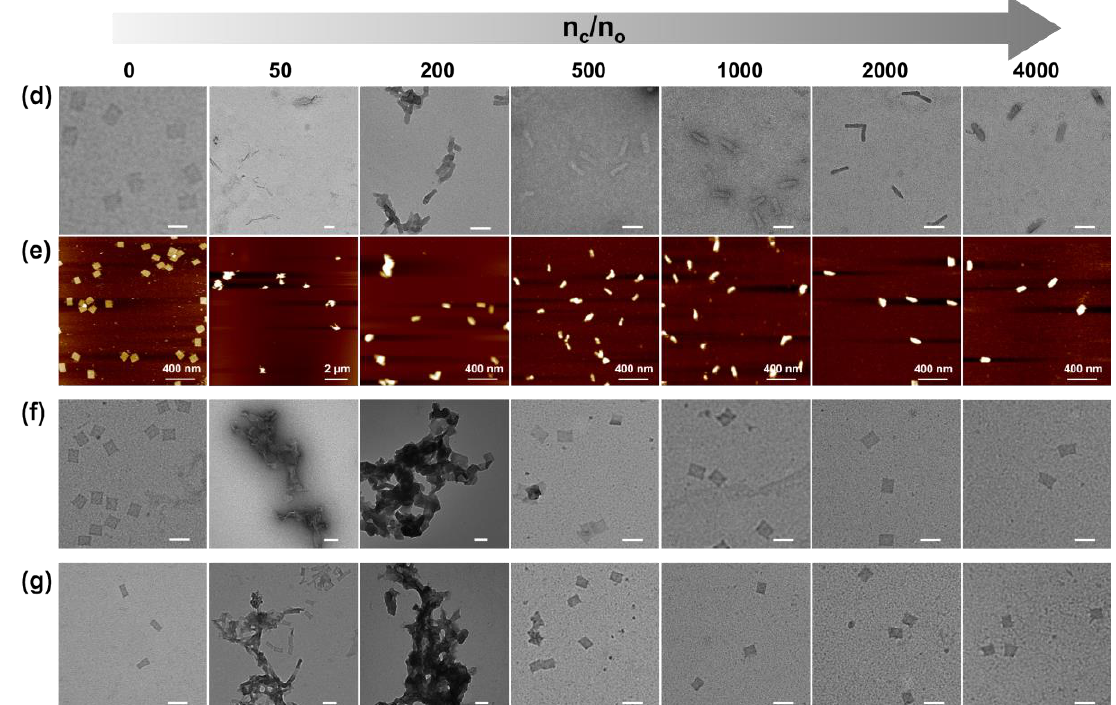
Figure 2. Gel EMSA and TEM, AFM micrographs of the samples. ( a ) Agarose gel EMSA of Orig1 and coated Orig1 with increasing ratios of n c /n o ; ( b ) Gel EMSA of Orig2 and coated Orig2 with increasing ratios; ( c ) Gel EMSA of Orig3 and coated Orig3 with increasing ratios; ( d ) TEM images of Orig1 and coated Orig1 with increasing ratios of nc/no; ( e ) AFM images of Orig1 and coated Orig1 with increasing ratios; ( f ) TEM images of Orig2 and coated Orig2 with increasing ratios of nc/no; ( g ) TEM images of Orig3 and coated Orig3 with increasing ratios of nc/no, scale bar in all TEM images is 100 nm.